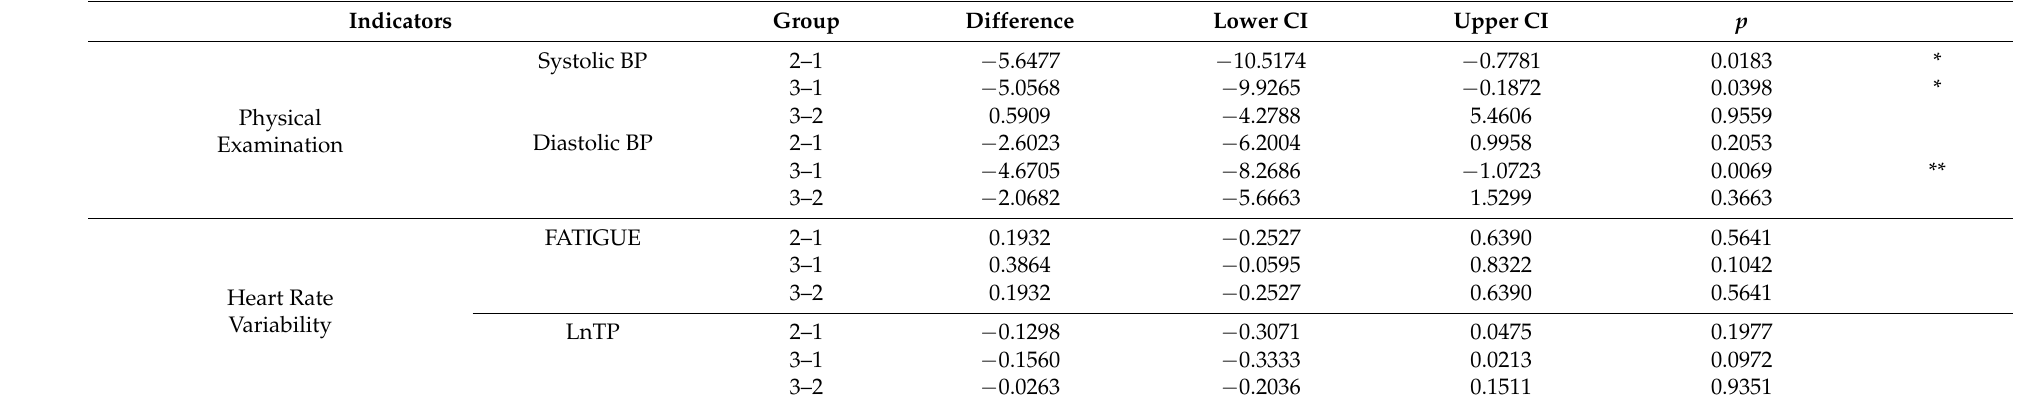
Table A2. Result Table of Tukey’s Test for Post hoc